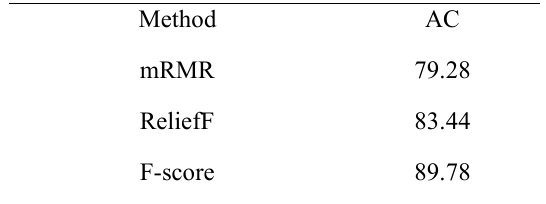
Table 4. Comparison results of different feature selection methods/%